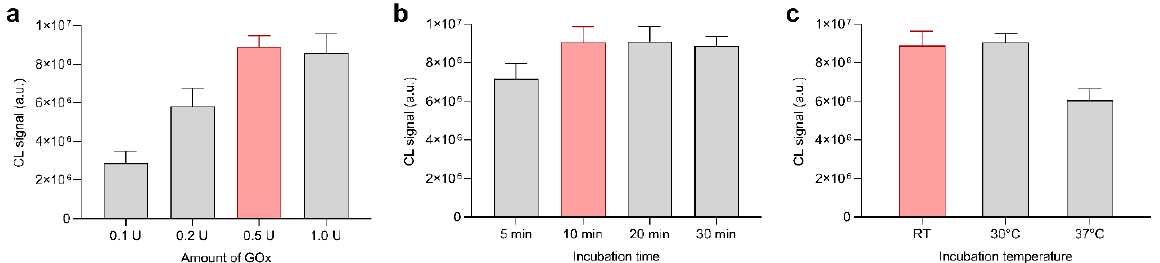
Figure 6. Optimization of experimental conditions for glucose detection, performed by analyzing 10 µL of a 250 µmol L −1 glucose standard solution (the selected conditions are highlighted). ( a ) CL signals obtained in origami µPADs containing different amounts of GOx. ( b ) CL signals obtained with different incubation times. ( c ) CL signals obtained with different incubation temperatures. In each measurement, the optimal values for the other experimental conditions were used. Room temperature (RT) varied between 20 and 25 °C. Each value is the mean ± SD of six measures performed in three origami µPADs.